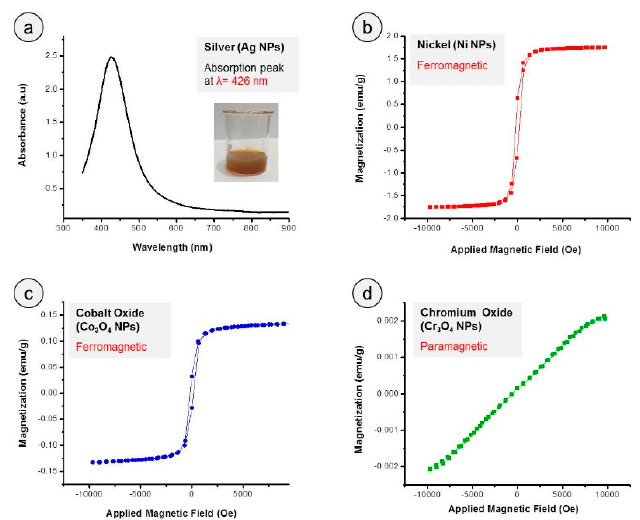
Figure 5. ( a ) UV-visible absorption spectra of AgNPs showing a single characteristic peak. The inset displays the color of colloidal AgNPs sample in a beaker. ( b – d ) Magnetic hysteresis loops of NiNPs, cobalt oxide NPs, and chromium oxide NPs demonstrating the ferromagnetic behavior of NiNPs and cobalt oxide NPs while paramagnetic nature of chromium oxide NPs. Table 2. Measured magnetic parameters of prepared magnetic nickel and cobalt oxide NPs. Sample